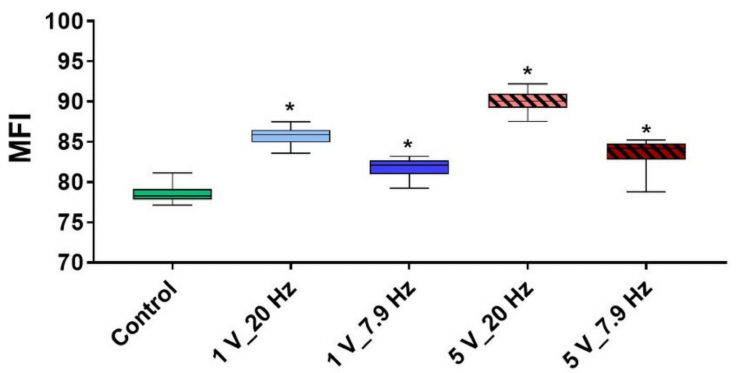
Figure 8. The level of intracellular calcium ions (Ca 2+ ) in MG-63s within 10 min AC stimulation. Note that electrical stimulation activates the cells resulting in significantly higher Ca 2+ levels in cells compared to the unstimulated Control. (LSM780, Carl Zeiss; time series of 30 cycles each 2 s started after 5 min settling phase of MG-63s; 7 independent experiments of defined areas of 10 cells, i.e., 70 cells per time point; median ± min/max; Friedman test posthoc uncorrected Dunn’s test, * p < 0.05 compared to